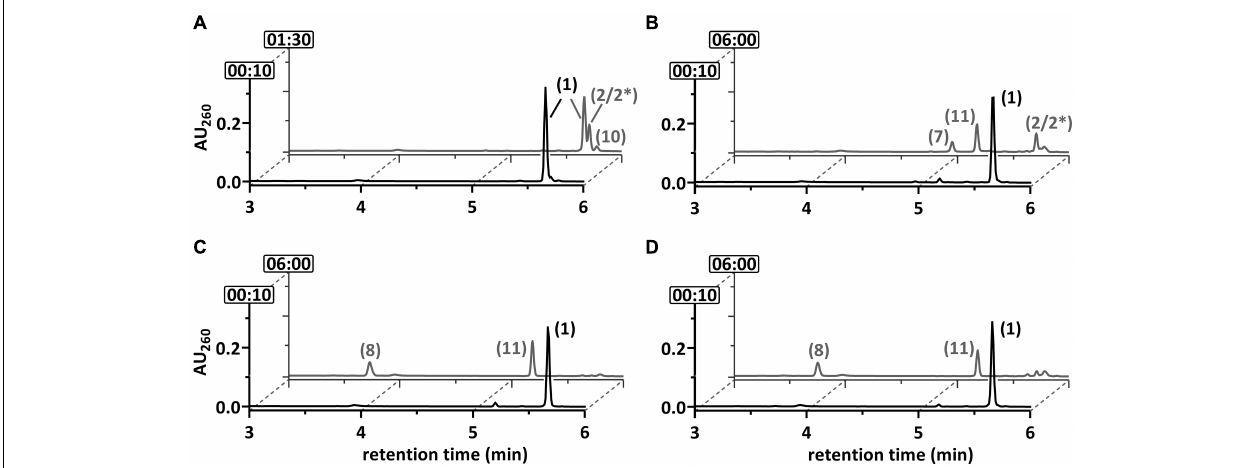
FIGURE 4 | Ultraperformance liquid chromatography diagrams demonstrating the time-dependent conversion of 2-F-BzCoA (1) by (A) BCR, (B) BCR+DCH, (C) BCR+DCH+OAH and (D) BCR+OAH. UPLC analyses of samples are shown, that were taken at representative time points as indicated by the numbers (min) at the y -axis. The peak numbers refer to those assigned to structures in Figures 1 , 7 : 2-F-BzCoA (1), F-1,5-dienoyl-CoA (2 and/or 2 ∗ ), 6-oxo-1-enoyl-CoA (7), 3-OH-pimeloyl-CoA (8), F-1-enoyl-CoA (10) and F-OH-1-enoyl-CoA